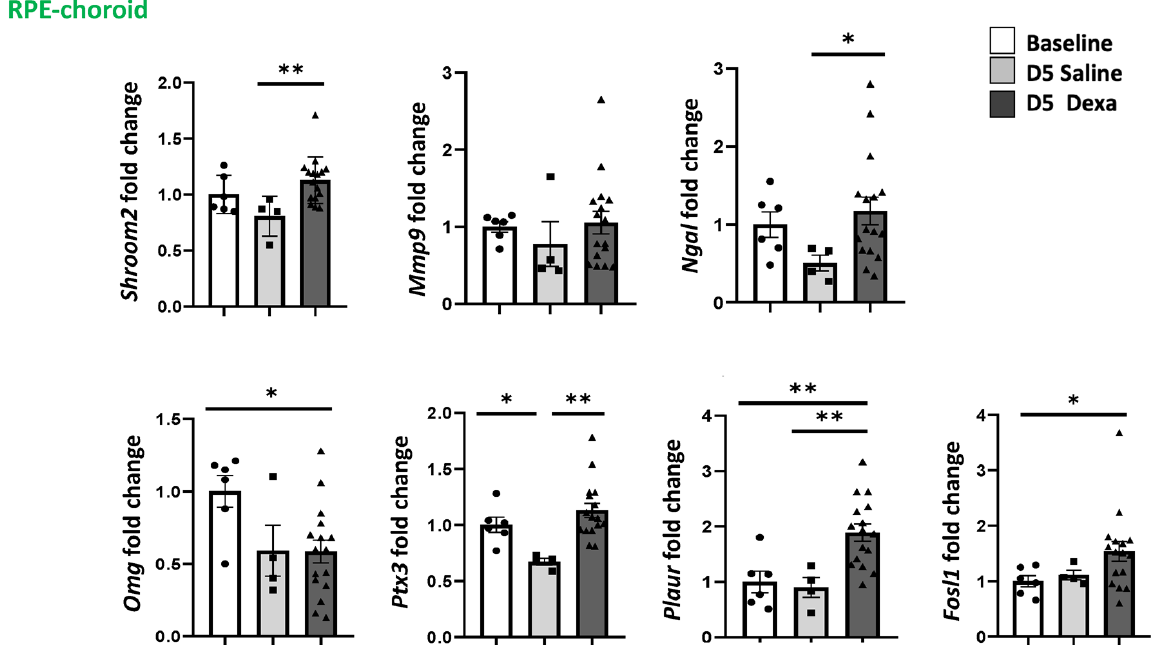
Figure 5. Regulation of MR-induced genes in the RPE/choroid. Expression of Shroom 2 , Ngal , Mmp9 and Omg , Ptx3 , Plaur and Fosl-1 in the RPE/choroid of rats at baseline ( n = 7), after 5 days of daily injection of dexamethasone ( n = 16) or saline ( n = 6), * p < 0.05, ** p < 0.01.